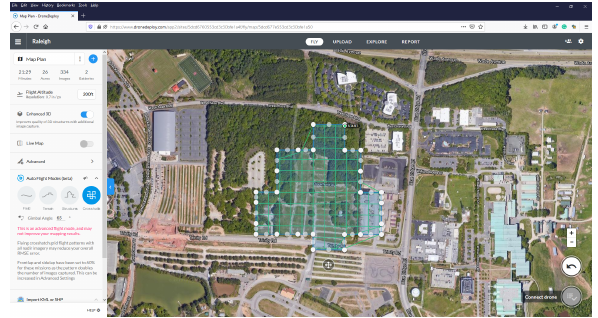
Figure 4: Flight area generated by using a GRASS GIS script, which utilizes a moving window resampling method to generate 10 acre polygons displayed in the DroneDeploy flight planning software.